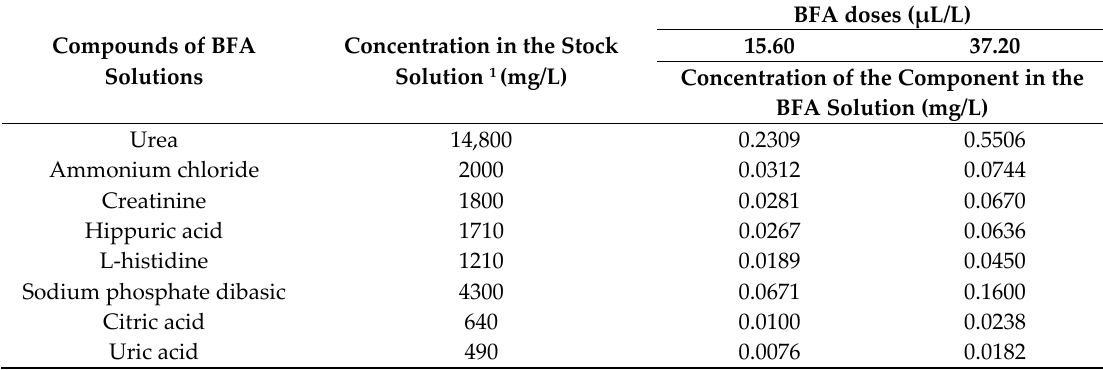
Table 1. Concentration of body fluid analogue (BFA) components in the tested solutions.